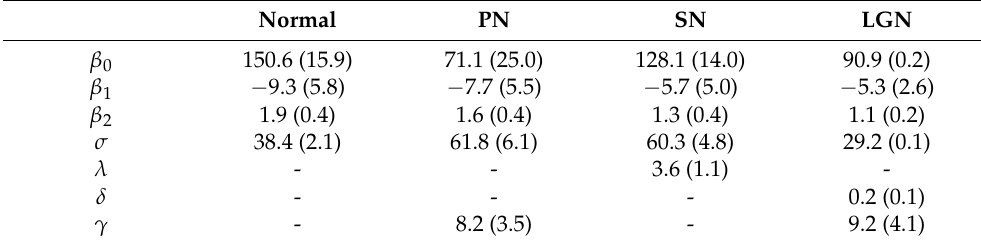
Table 4. Estimates and standard error (SE) for normal, PN, SN and LGN linear regression models fitted to cholesterol